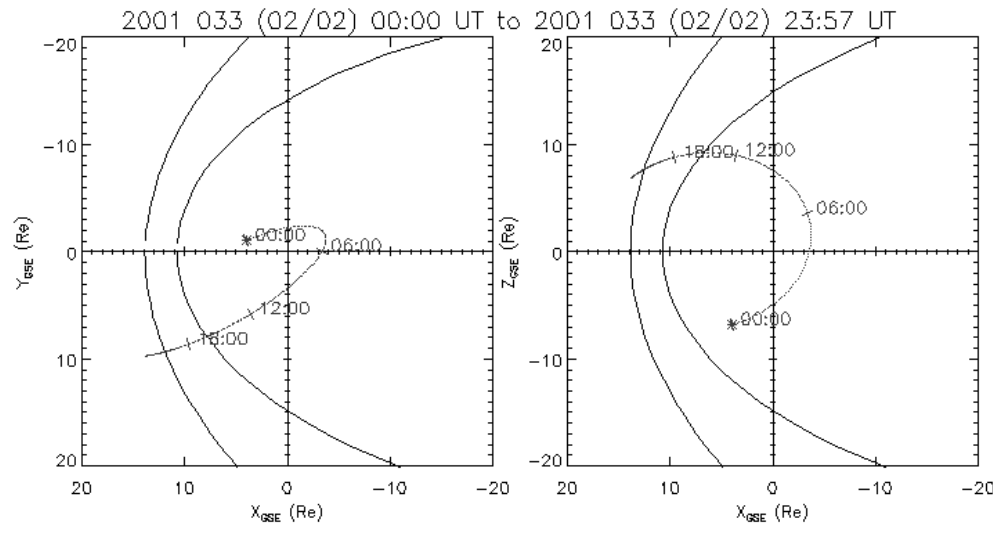
Fig. 1. Cluster orbit in GSE coordinates in the ( X,Y ) and ( X,Z ) planes. The star shows the location of the satellites at